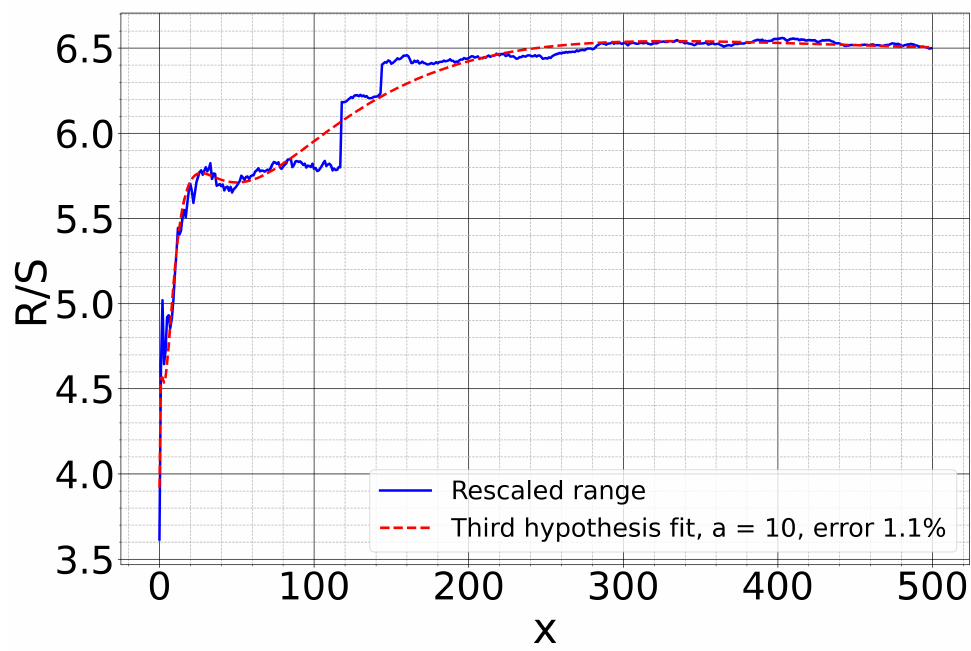
Figure 4. Fitting of AT-2020USB+ microphone differential noise (Hypothesis